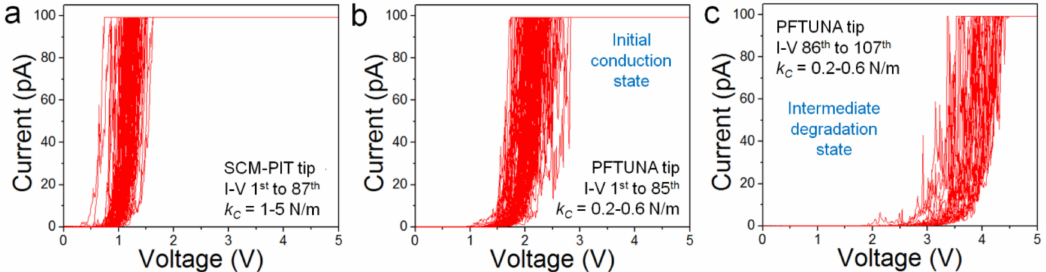
Figure 2. ( a ) 87 I-V curves collected at different locations of the TiO 2 /SiO x /n ++ Si sample using a SCM-PIT probe. ( b ) Initial 85 I-V curves and ( c ) final 22 I-V curves collected at different locations of the same sample using a PFTUNA probe (the same for both panels). These I-V curves were obtained under atmospheric environment (normal air). The X-axis represents the tip voltage, while the sample holder was